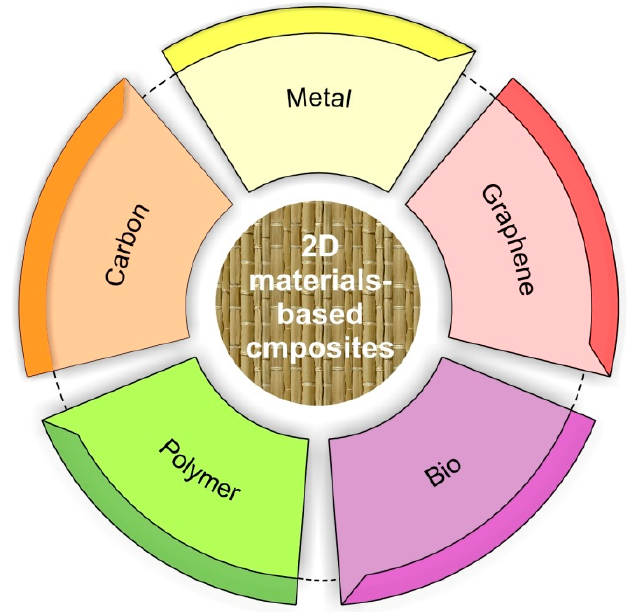
Figure 5. Classification of 2D materials-based composites.